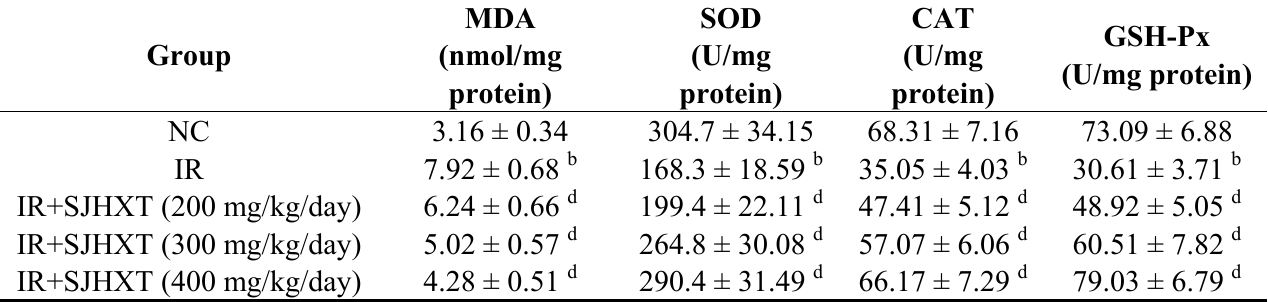
Table 5. Effect of SJHXT on skeletal muscle MDA level, SOD, CAT and GSH-Px